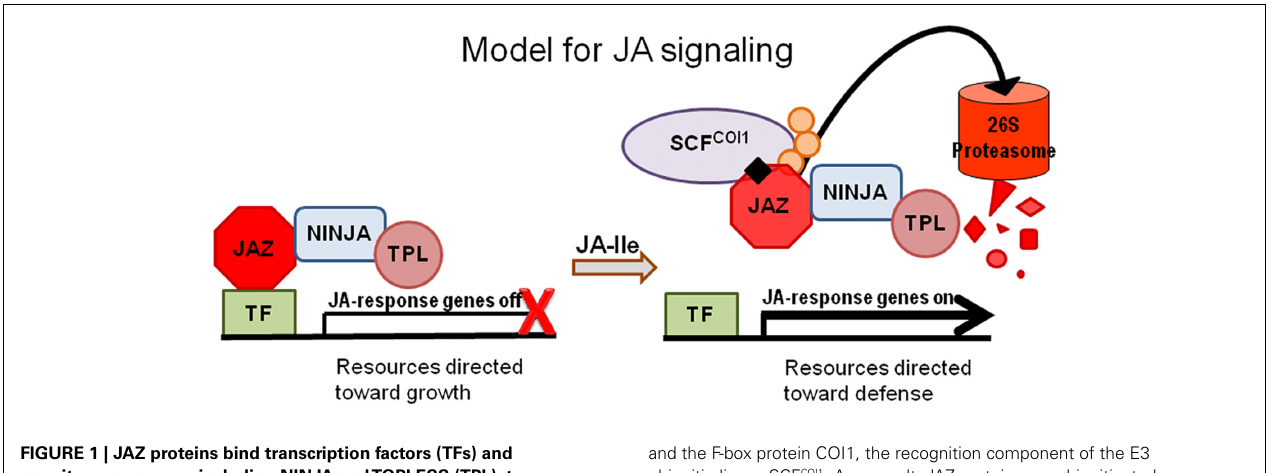
FIGURE 1 | JAZ proteins bind transcription factors (TFs) and recruit co-repressors, including NINJA andTOPLESS (TPL), to repress gene transcription in the absence of the active form of jasmonate (JA), JA–Ile (black diamond). In the presence of JA–Ile, the hormone facilitates interaction between JAZ proteins